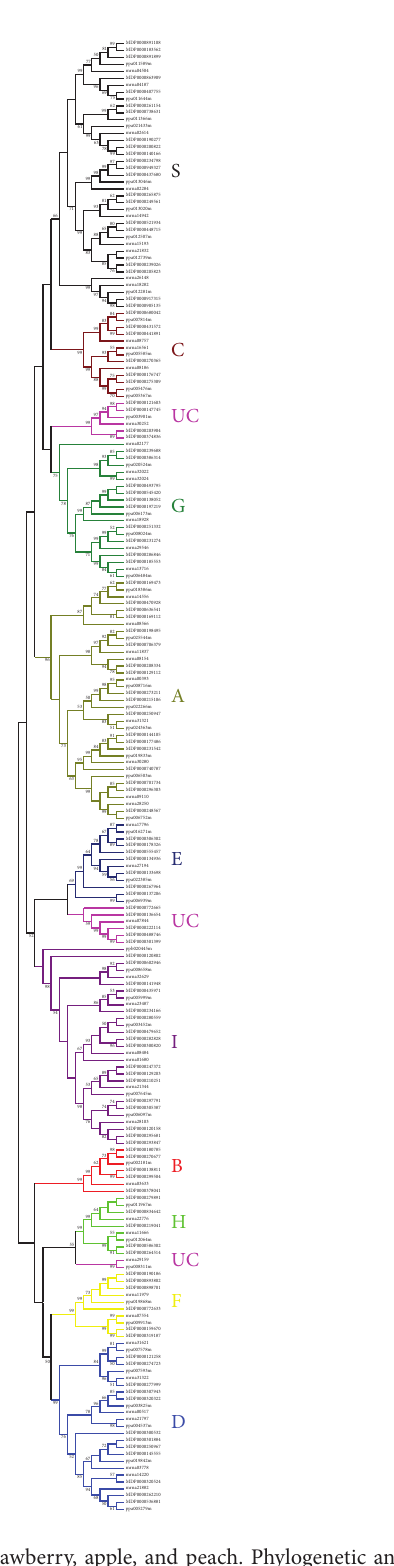
Figure 2: Phylogenetic analysis of bZIP members in strawberry, apple, and peach. Phylogenetic analysis of bZIP proteins in strawberry (mrna), apple (MDP), and peach (ppa). Only bootstrap values larger than 50% are indicated. Different colors can be used to distinguish the different subgroups. The names of each subgroup are listed on the right. UC represented “unique